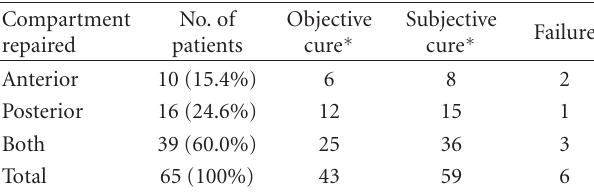
Table 2: Success and failure rates according to the compartment repaired.